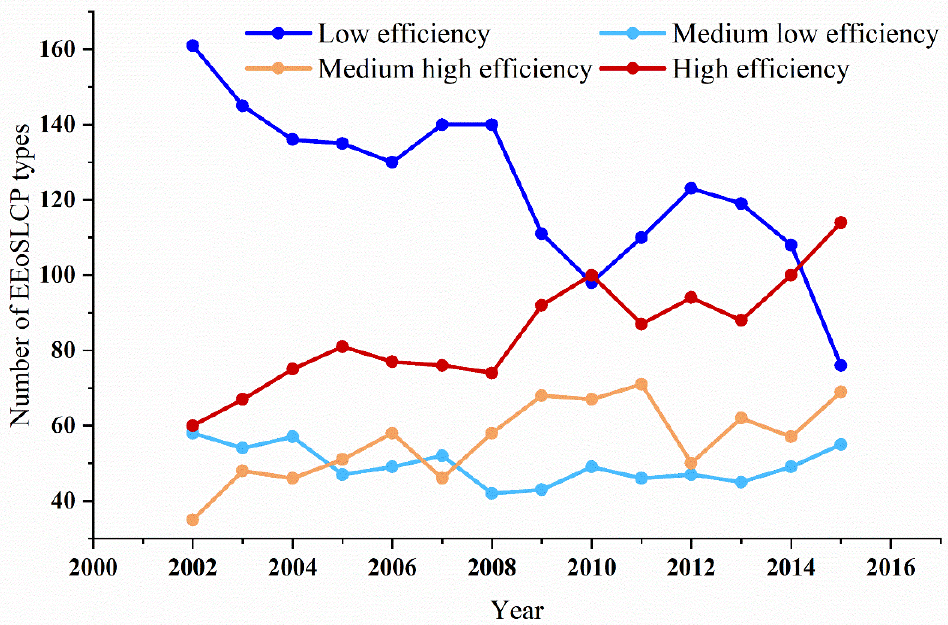
Figure A1. Quantitative changes of four EEoSLCP types in counties, 2002 to 2015. Table A1. Global Moran’s I value and its test results of EEoSLCP in the LP from 200 2 to 2015.